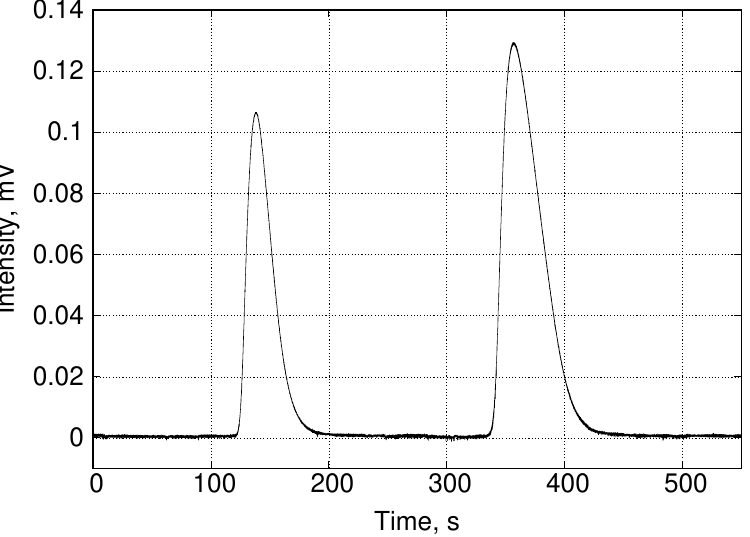
Figure 6. Chromatogram corresponding to the methane/ethane mixture in the analytical